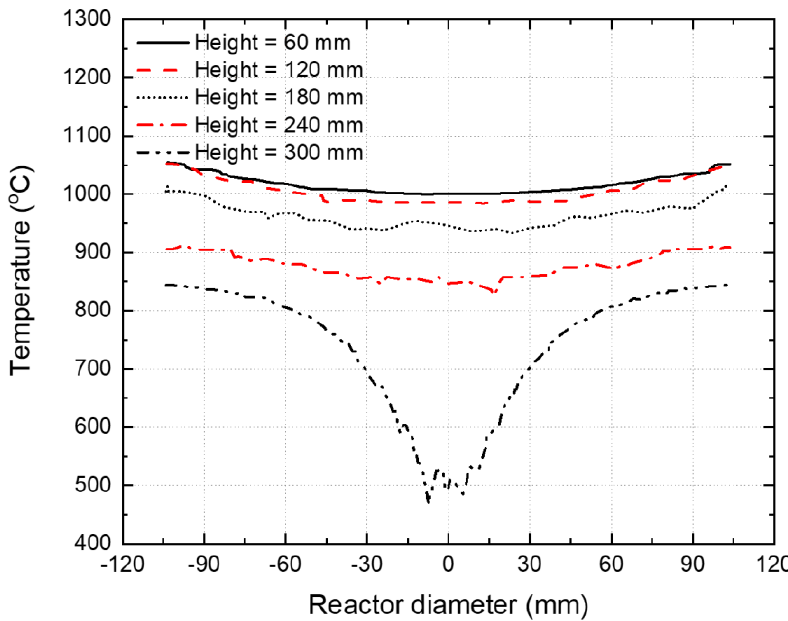
Figure 20. Temperature distribution by height in the reactor (semi-cavity).